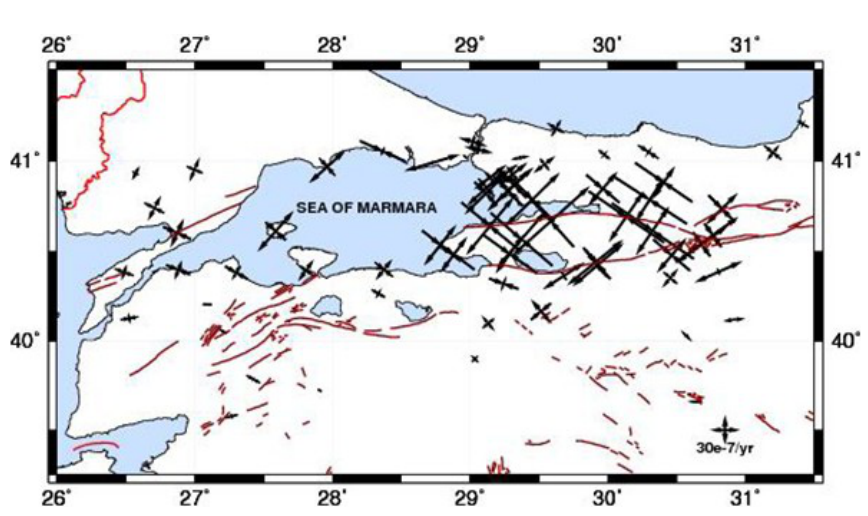
Fig. 4. Principal strain parameters of each group.